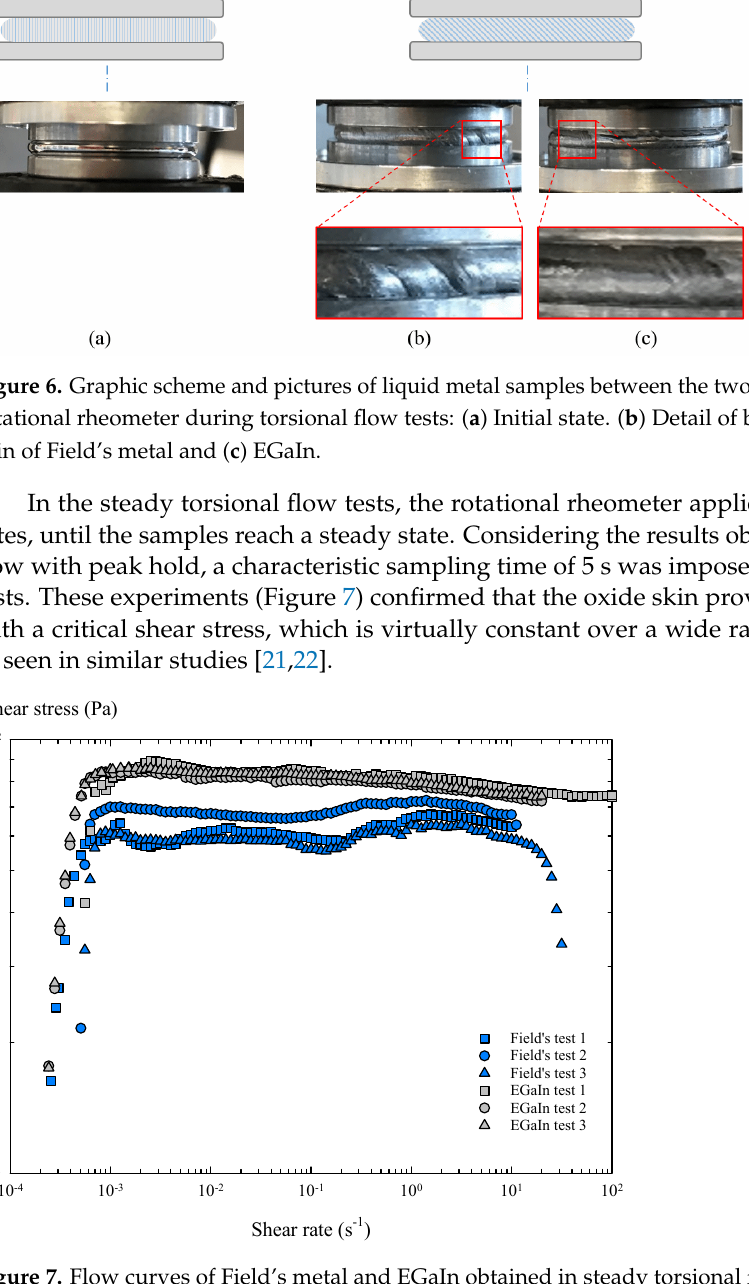
Figure 7. Flow curves of Field’s metal and EGaIn obtained in steady torsional flow